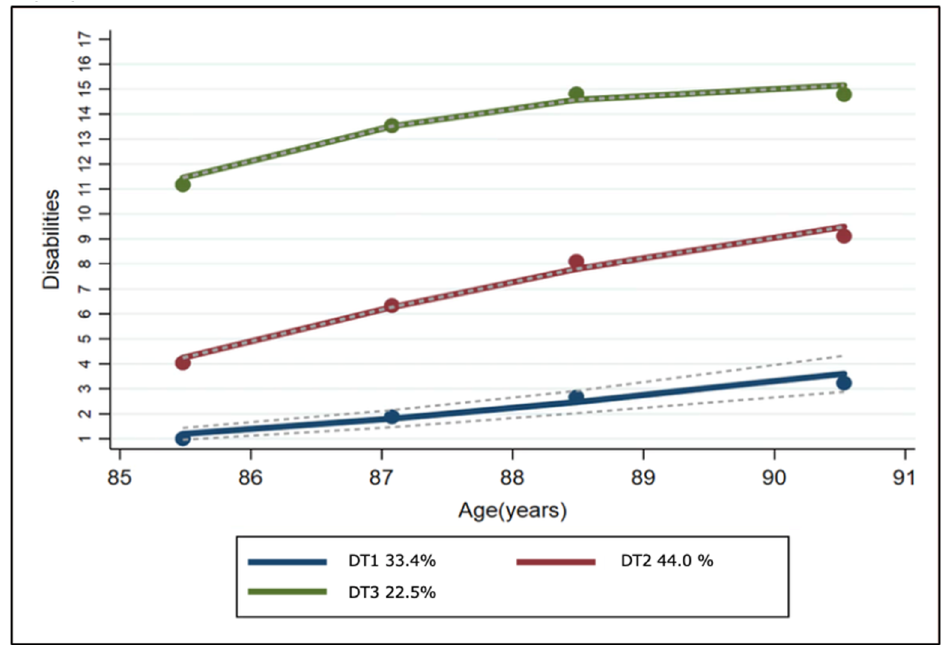
Figure 1. Disability trajectories with 95% confidence intervals in participants who had a serum 25(OH)D measurement available. DT1: Low to mild disability trajectory; DT2: Mild to moderate disability trajectory; DT3: Moderate to severe disability trajectory. Percentages represent group size. Disabilities resulted from calculating ADLs, IADLs and mobility. The grey dotted lines represent the 95% confidence intervals of the disability trajectories. ADL: activities of daily living, IADL: instrumental activities of daily